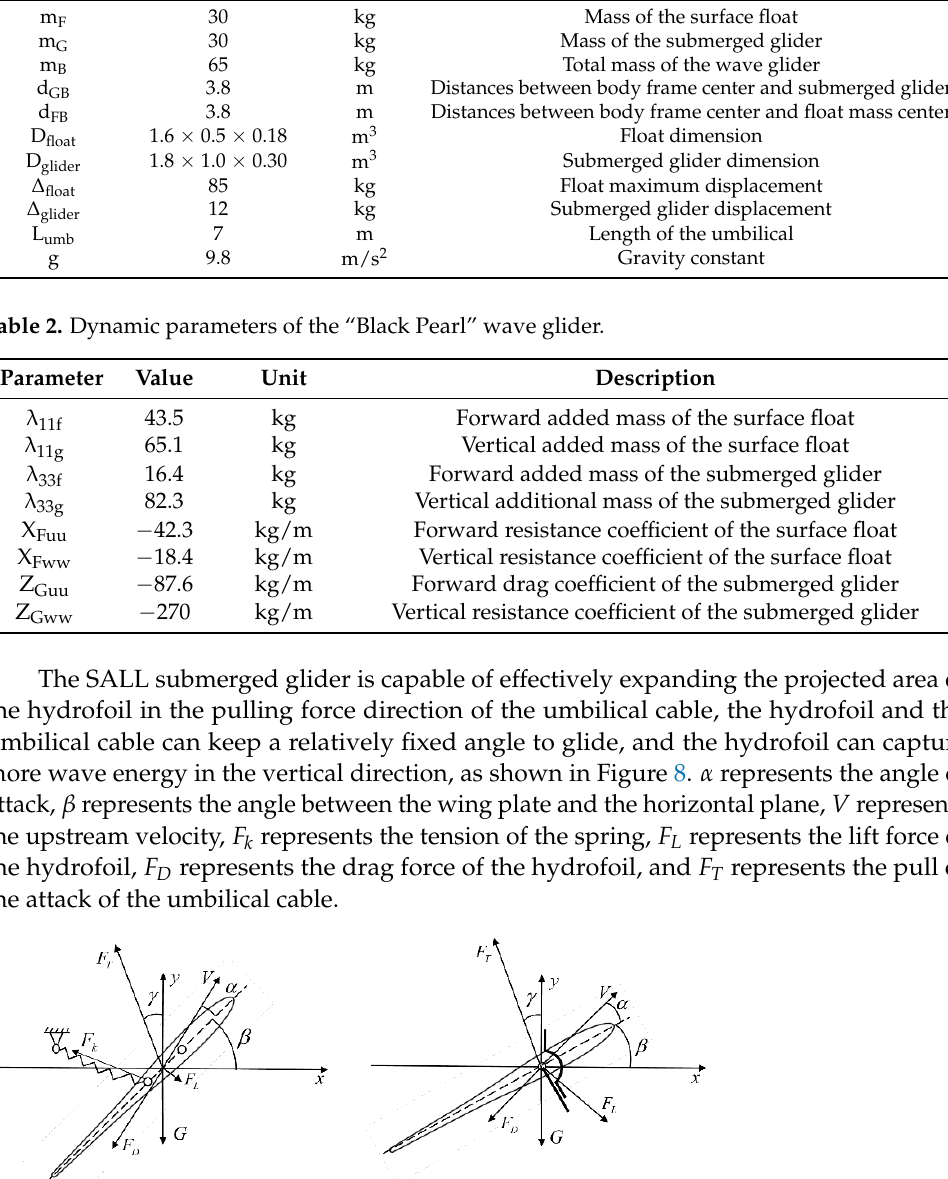
Table 3. Main parameters of the hydrofoil.